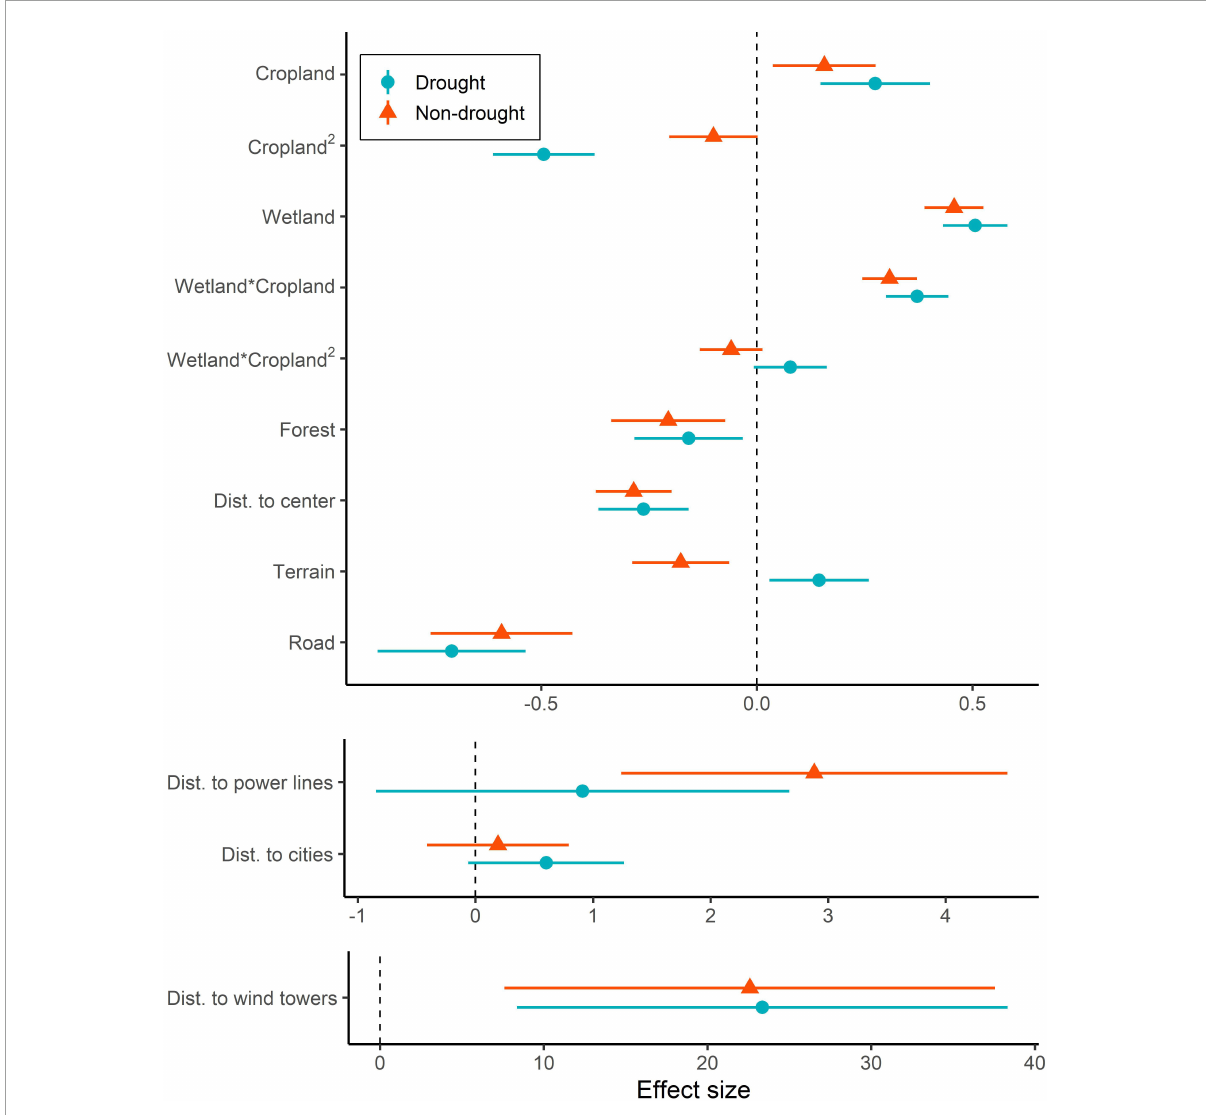
FIGURE1 Population-level mean estimates and 95% credible intervals in drought and non-drought conditions from the final global model estimating resource selection functions of migrating whooping cranes ( Grus americana ) in the United States Great Plains, 2010–2016. Vertical dotted lines designate an effect of zero. Note that x -axes differ to allow for visualization of effects that vary in